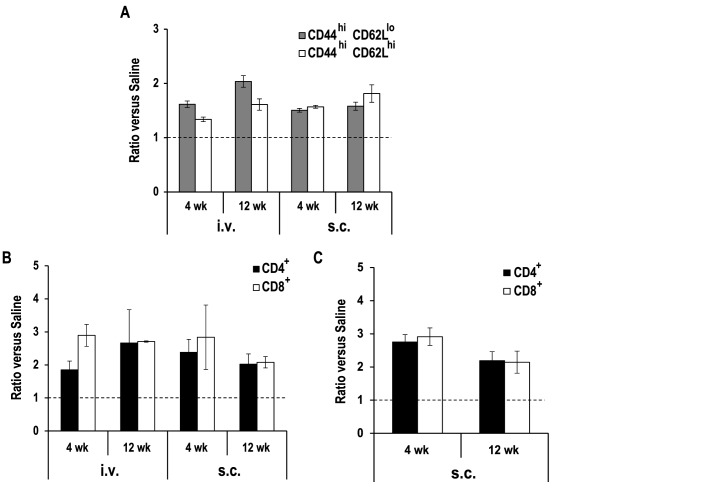
Analysis of splenic T cell populations in vaccinated mice.Mice (n = 4 per group) were inoculated with PBS (Saline; s.c.) or with 1 × 107
LiΔHSP70-II promastigotes in the vein tail (i.v.) or in the right footpad (s.c.). After 4 weeks (vaccinated) and 12 weeks (saline and vaccinated), T cells from the spleen were studied in pool by flow cytometry. Animals were age matched at the moment of the analysis. In (A) analyzed CD4+ T cells were: antigen-experienced cells CD44high, central memory T cells (Tcm) CD44highCD62Lhigh and effector T cells or effector memory T cells (Teff/Tem) CD44highCD62Llow. Spleen cells (B) or right popliteal lymph node cells (C) of the indicated groups were ex vivo stimulated by anti-CD3/anti-CD28 and treated with brefeldin A to block cytokine secretion. Cells were characterized by using anti-CD4 and anti-CD8 antibodies as well as by intracellular staining for IFN-γ. The ratio between the percentages of CD4+ or CD8+ producing IFN-γ cells in vaccinated animals versus saline ones, derived from two independent experiments is shown (mean ± standard error of mean).